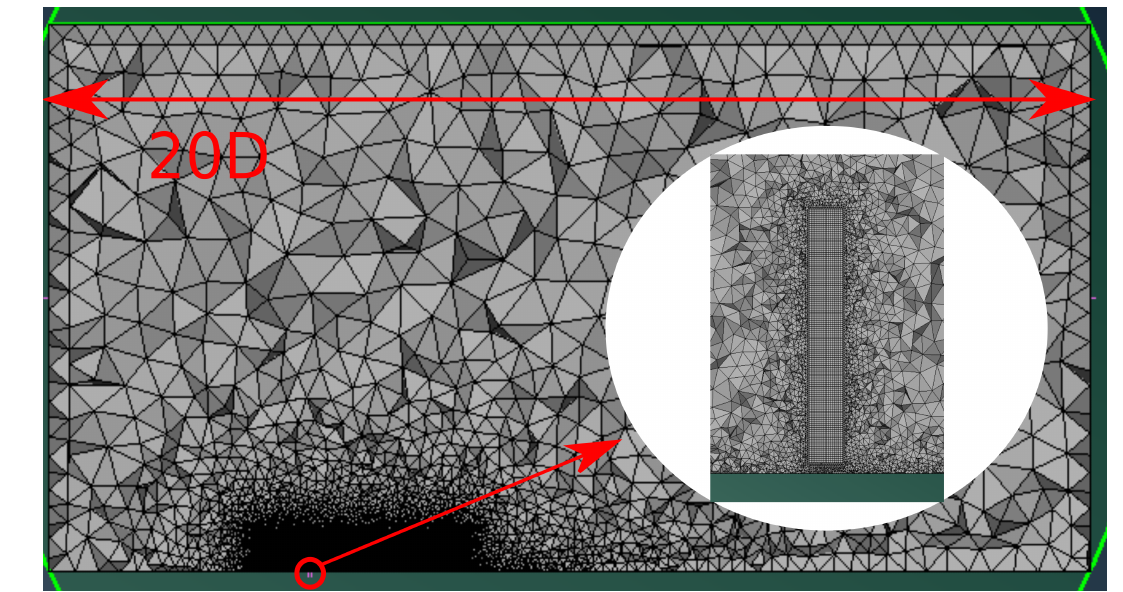
Figure 3. Periodic grid. Lateral view.